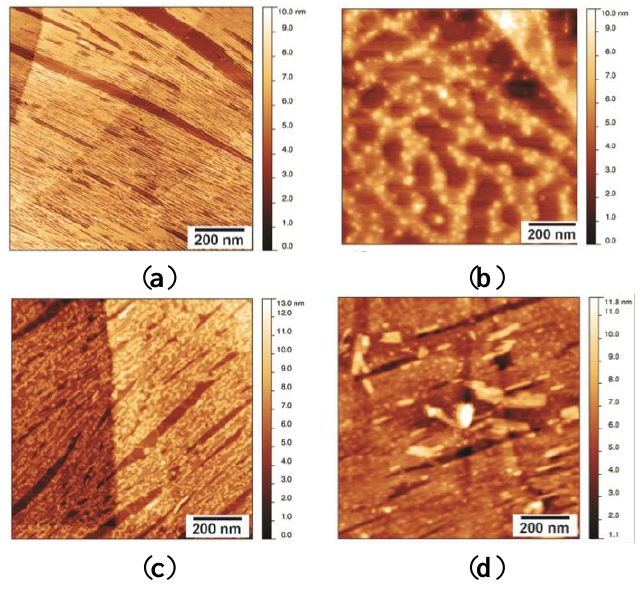
Figure 4. AFM scans of EAS rodlets on HOPG treated for 5 min with different ∆15